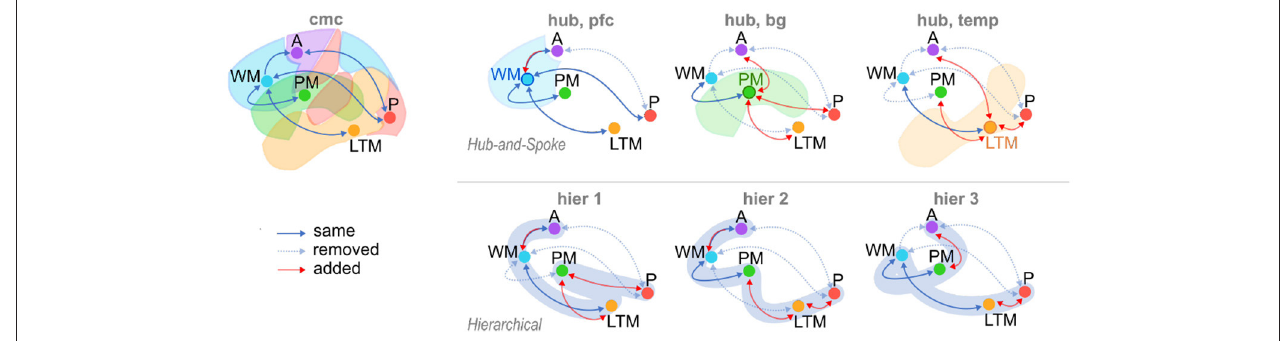
FIGURE 2 | The Common Model of Cognition (CMC) and six alternate model architectures. Alternate models consist of three variations of Hub-and-Spoke (hub) models, and three variations of Hierarchical (hier) models. Arrows: “same,” connections present in both CMC and candidate models (solid blue); “removed,” connections present in CMC and removed in candidate models (dotted blue); “added,” connections added to candidate models and absent in CMC